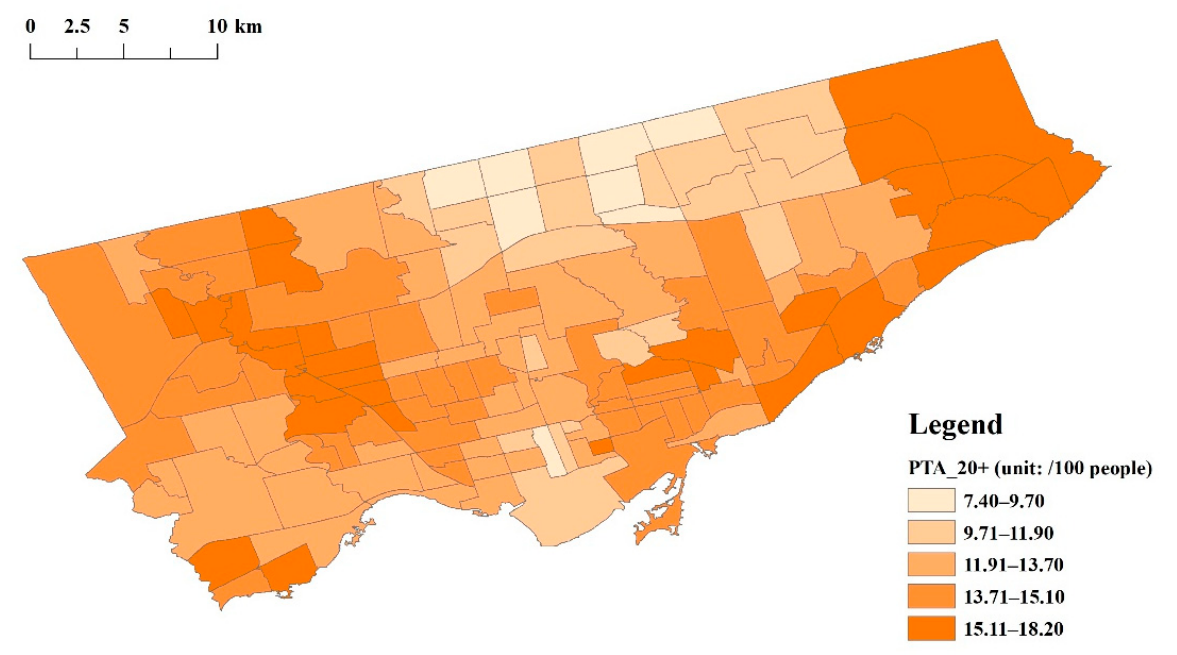
Figure A9. Distribution of the prevalence of total asthmatics aged 20 years and above (PTA_20+).